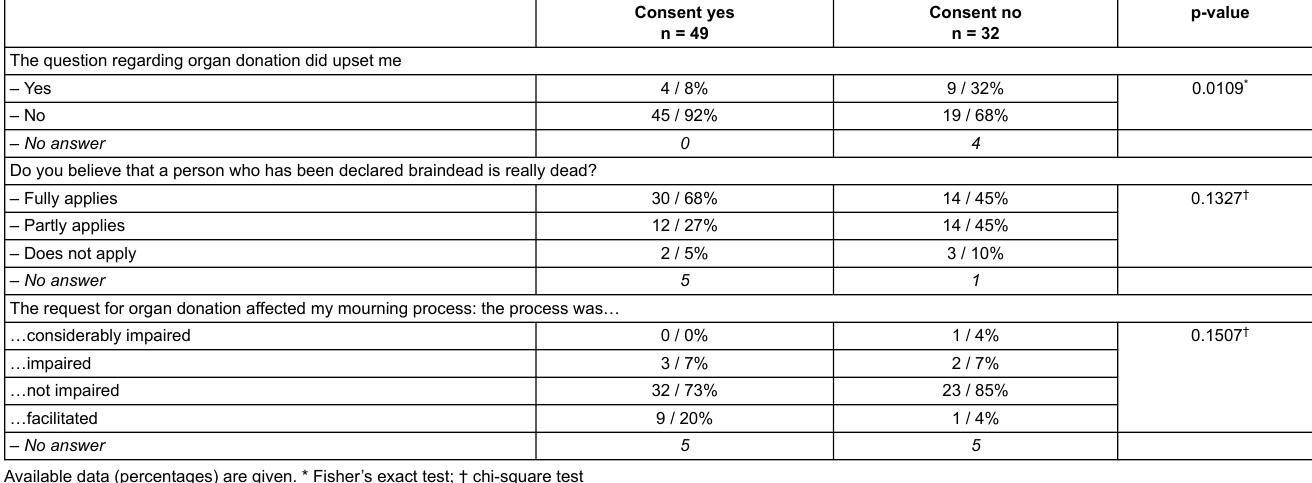
Table 3: Effect of consent, personal attitude towards organ donation and presumed will (if available) on the mourning process (71 answers, no answer = 10).